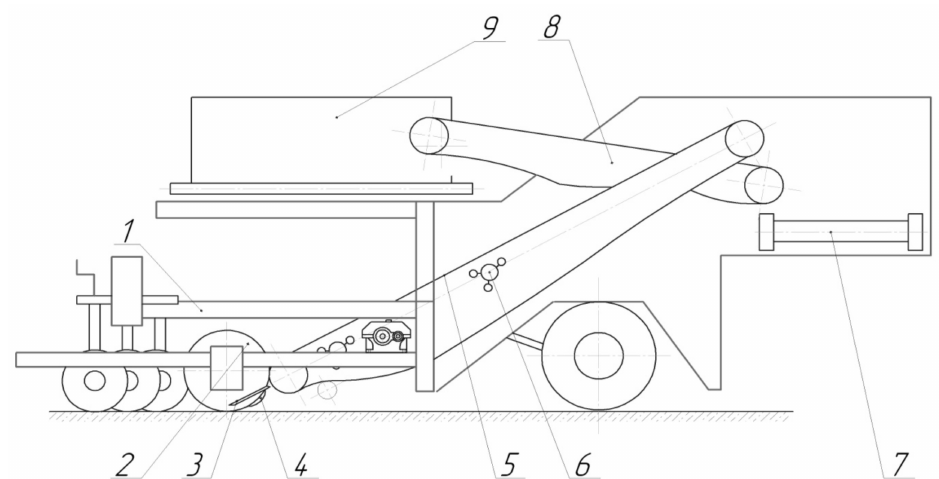
Figure 15. Structural and technological scheme of the combine “Bolko”: 1—frame; 2—vertical disks; 3—digging share; 4—support wheel; 5—main elevator; 6—shaker; 7—transverse elevator; 8—bulkhead table; 9—bunker.